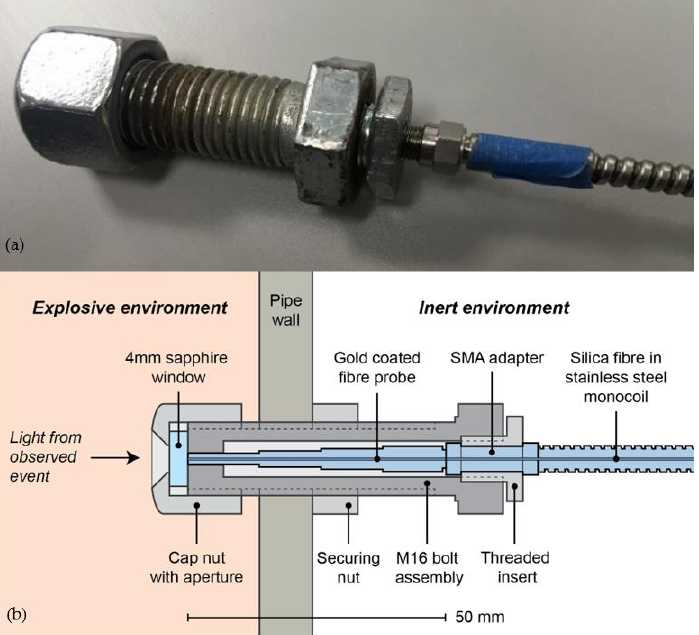
Figure 2. ( a ) Optical fibre probe within bolt for confined blast measurements. ( b ) Cross section of bolt used for glass measurement, indicating sapphire window.